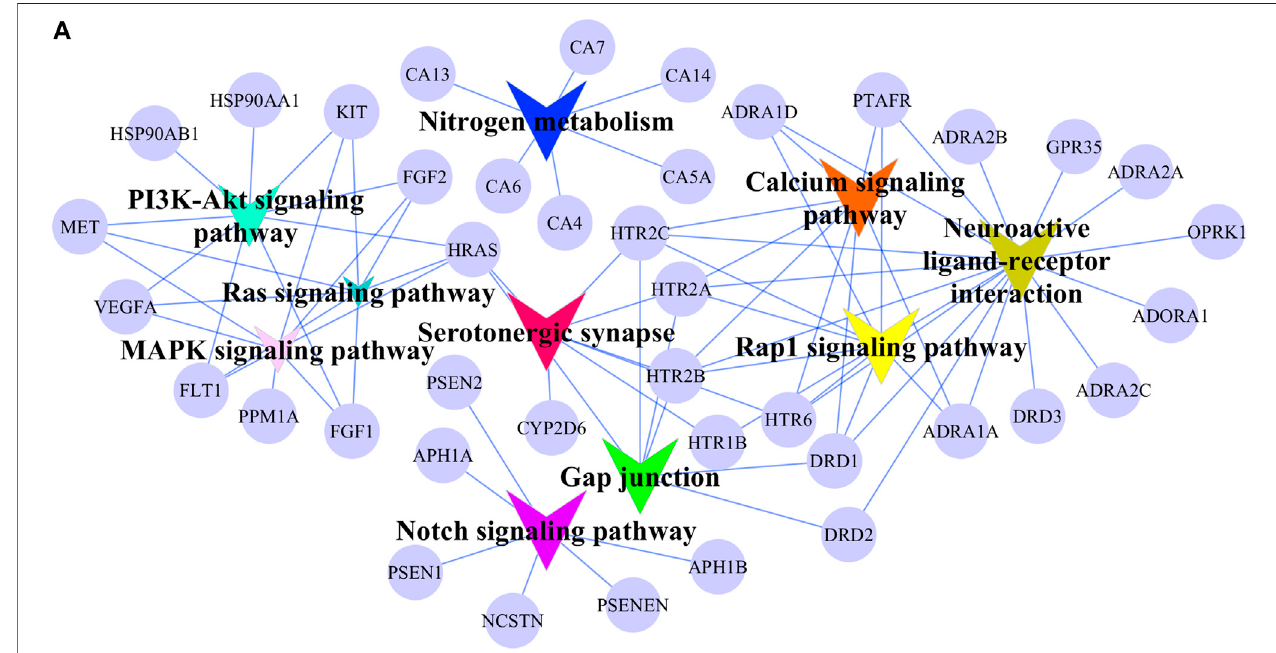
FIGURE 6 | Signaling pathway network of potential AA targets. The circular nodes represent potential AA targets. The V nodes represent signaling pathways and different colors represent different pathways.